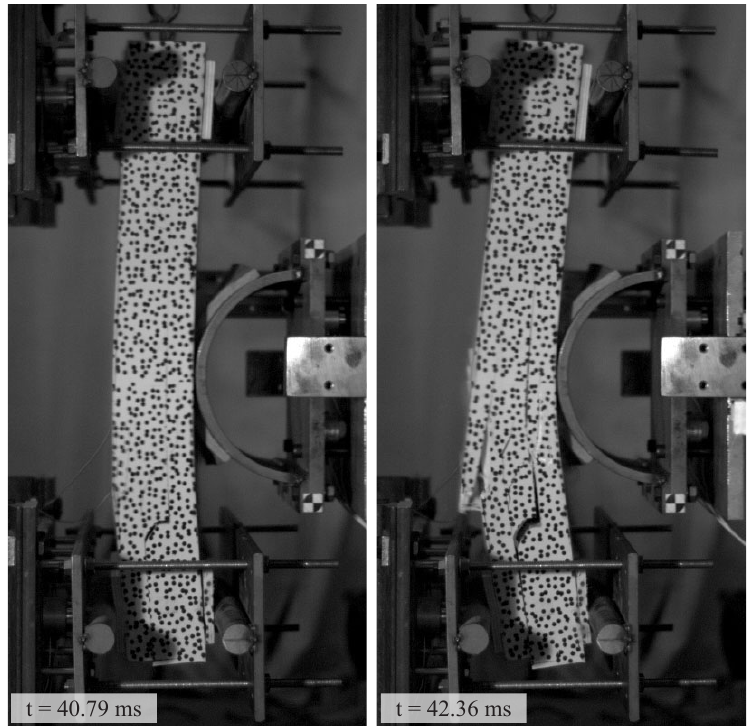
Figure 21. Comparison of damage in